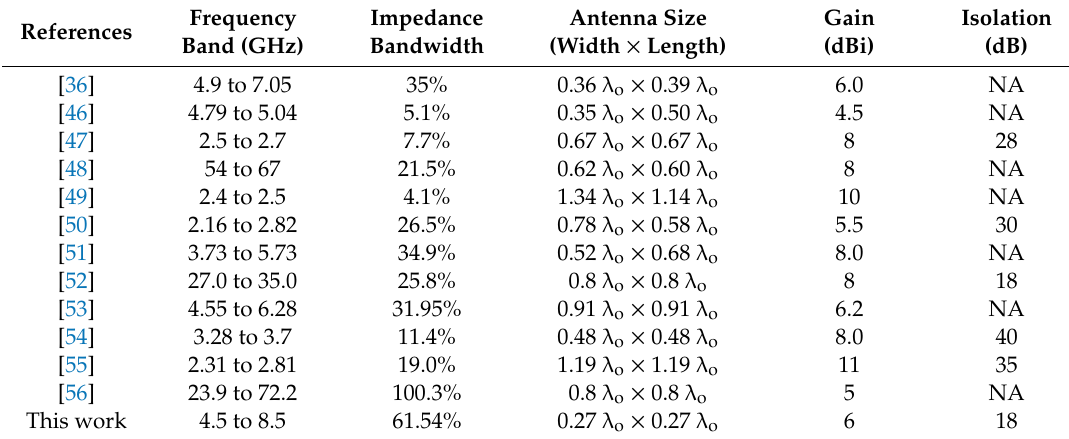
Table 4. Performance comparison of the proposed antenna.